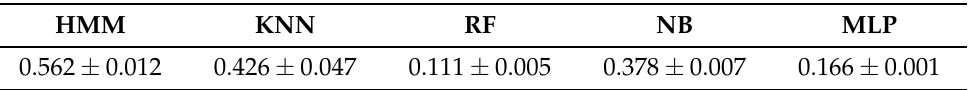
Table 8. Mean computational time (miliseconds) and the mean squared for classifying a measure of five consecutive samples for all algorithms. The database used was user2_centre. Each experiment was repeated 100